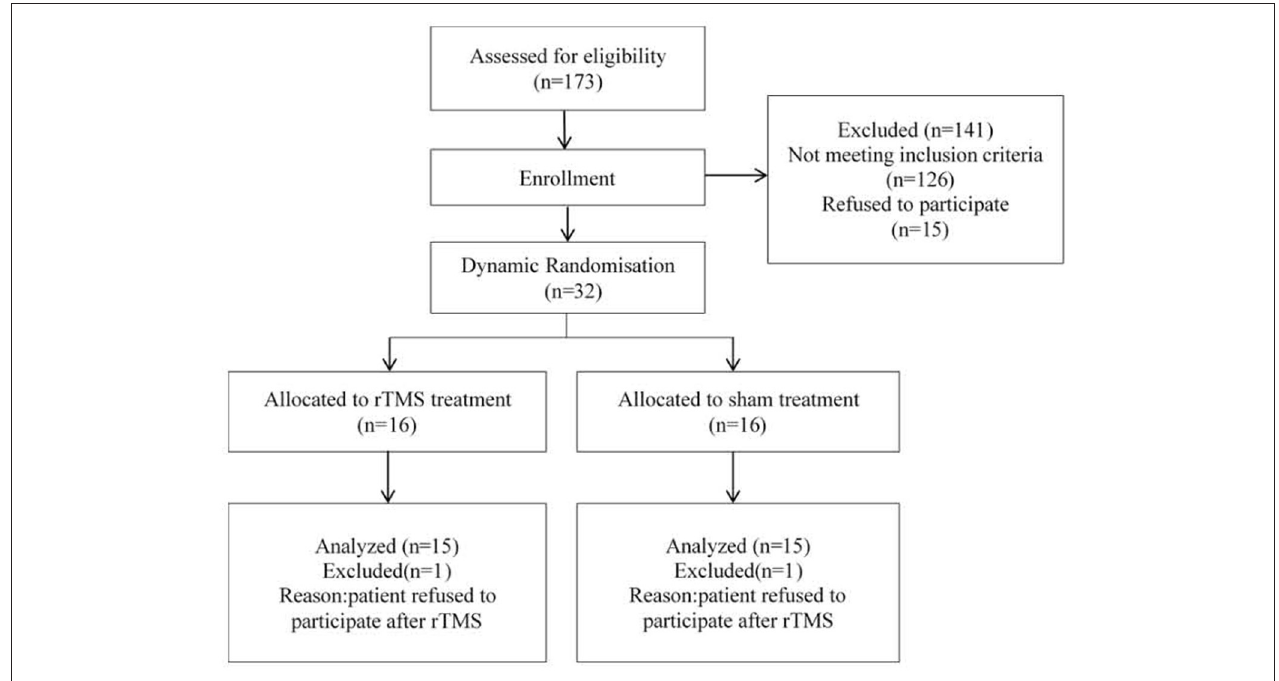
FIGURE 1 | Participant